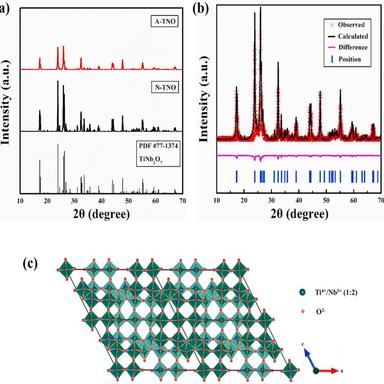
(a) XRD patterns of TiNb2O7 powders synthesized via the solid state method and the agar-assisted method, (b) Rietveld refinement results of TiNb2O7 powders synthesized via the agar-assisted method, and (c) crystal structure of TiNb2O7.